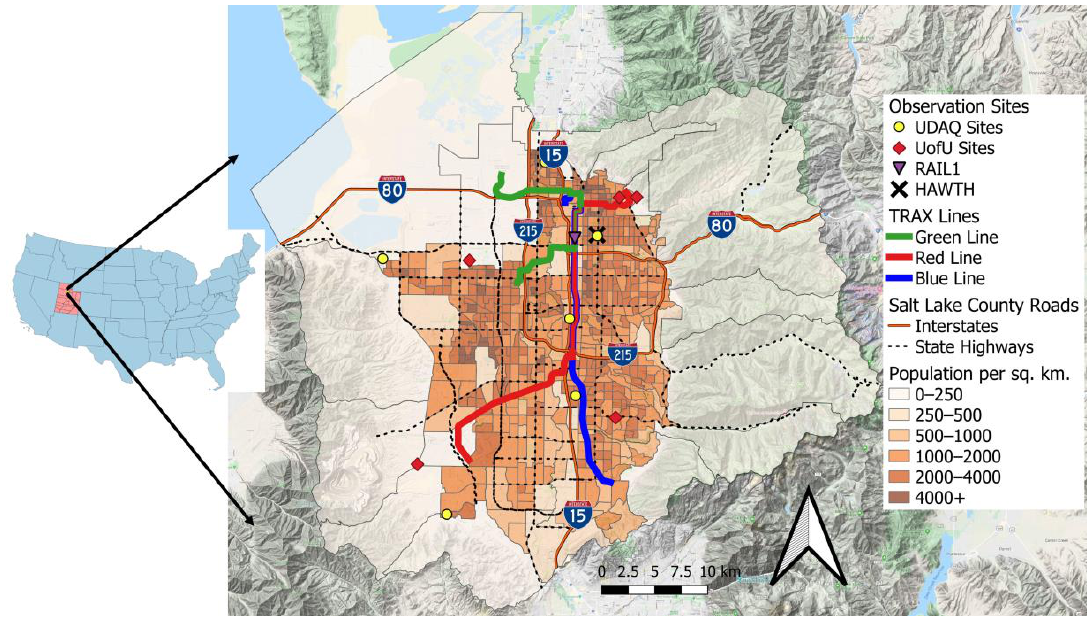
Figure 1. Salt Lake County study area. The TRAX light-rail observation sensors are on train cars traveling the Red, Green, and Blue lines that overlap along the central part of the network. The TRAX Observation Project “HAWTH” sensor (black X) is co-located with the Utah Division of Air Quality regulatory “HW” sensor (yellow circle) near the center of the map. Reproduced from [49]. UDAQ: Utah Division of Air Quality; UofU: University of